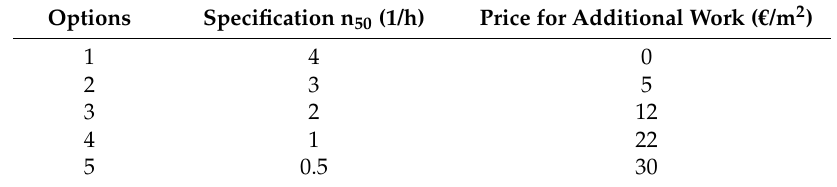
Table 7. Building tightness options.